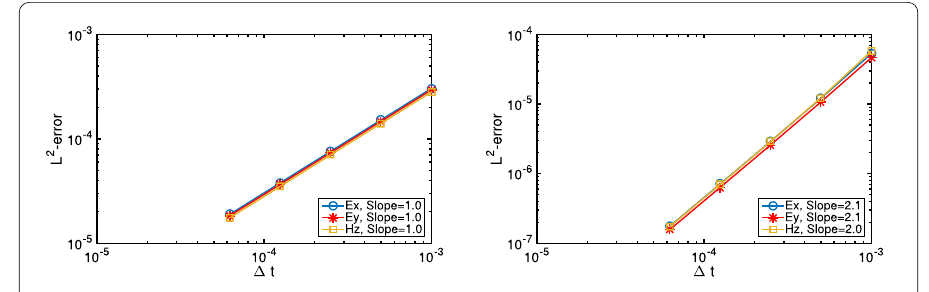
Figure 3 (cid:9) E M x – ˆ E M x (cid:9) , (cid:9) E M y – ˆ E M y (cid:9) and (cid:9) H M z – ˆ H M z (cid:9) versus (cid:7) t . Left: explicit leap-frog method; Right: L 2( (cid:4) ) L 2( (cid:4) ) L 2( (cid:4) ) predictor-corrector leap-frog method P(C) 1 (just one correction